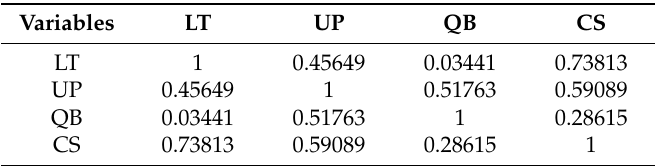
Table 14. The results of the Isotonicity